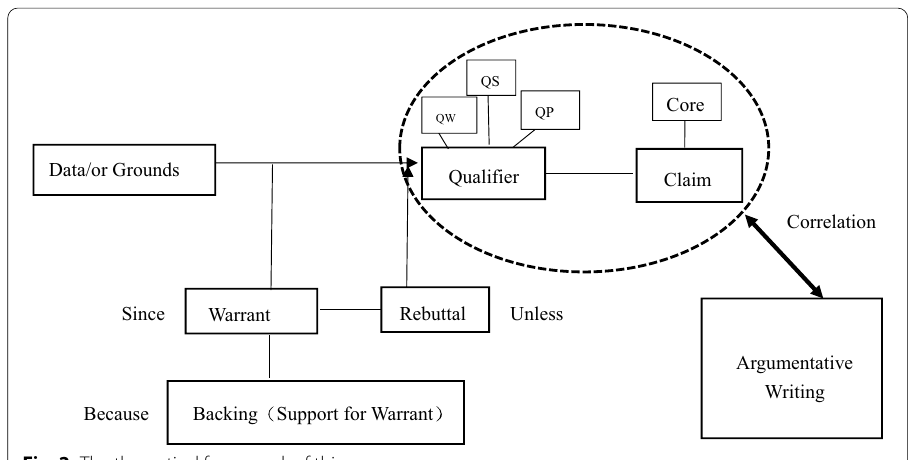
Fig. 2 The theoretical framework of this